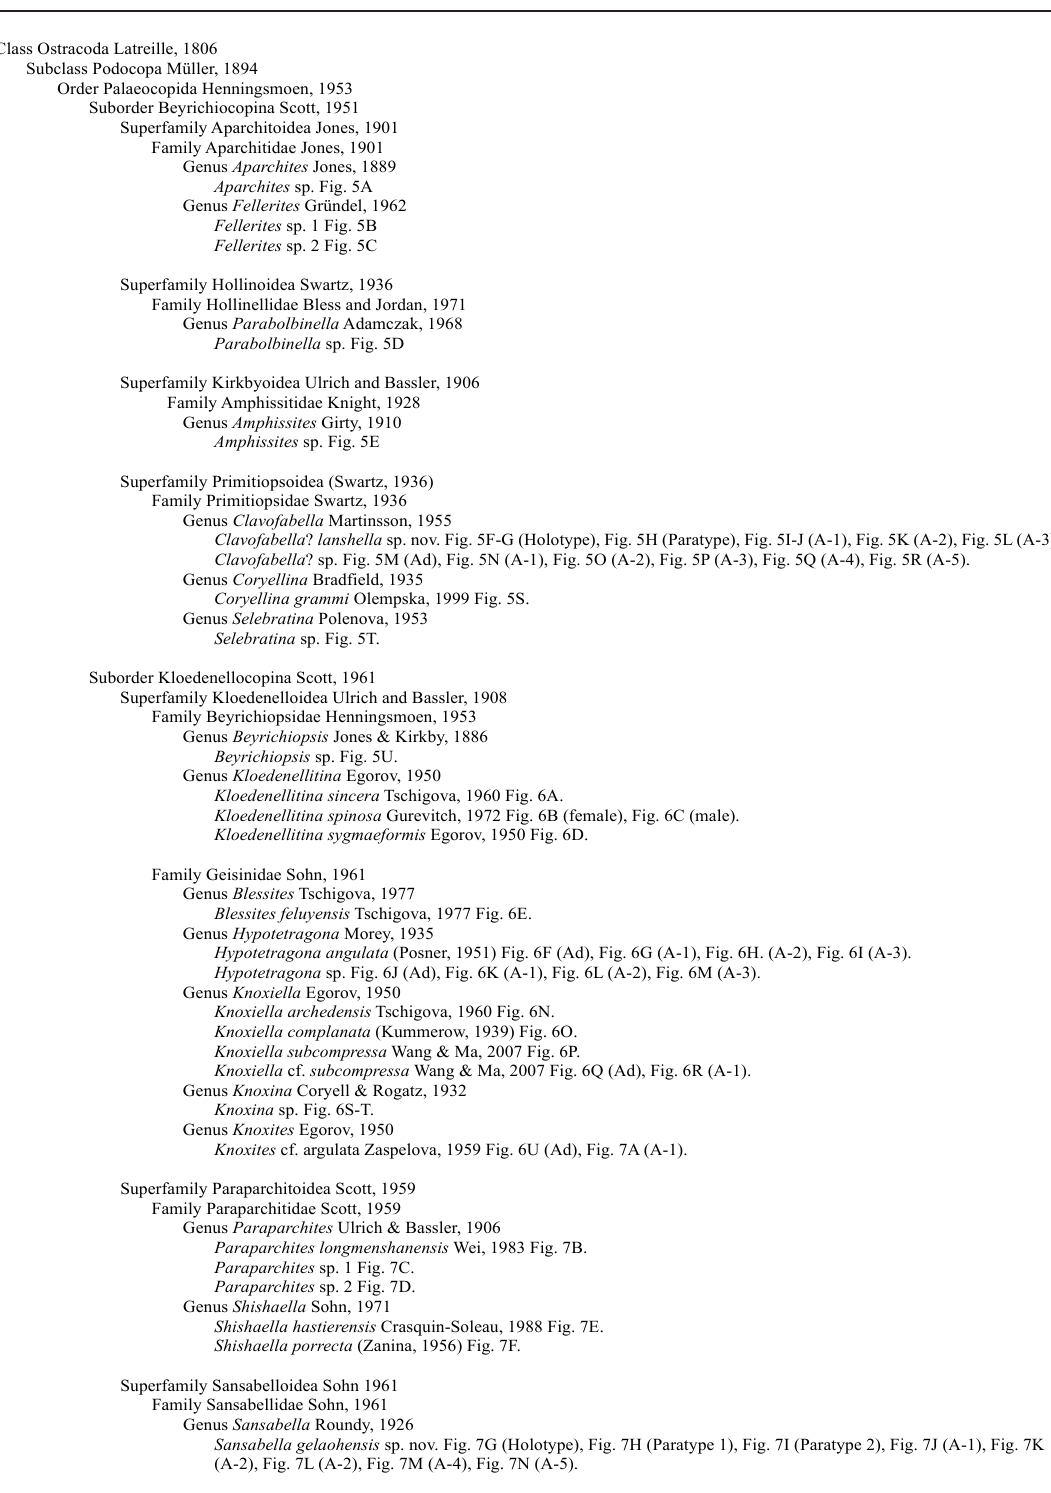
Snake section. Table 1. List and systematic placement of species occurring in the Blue Snake